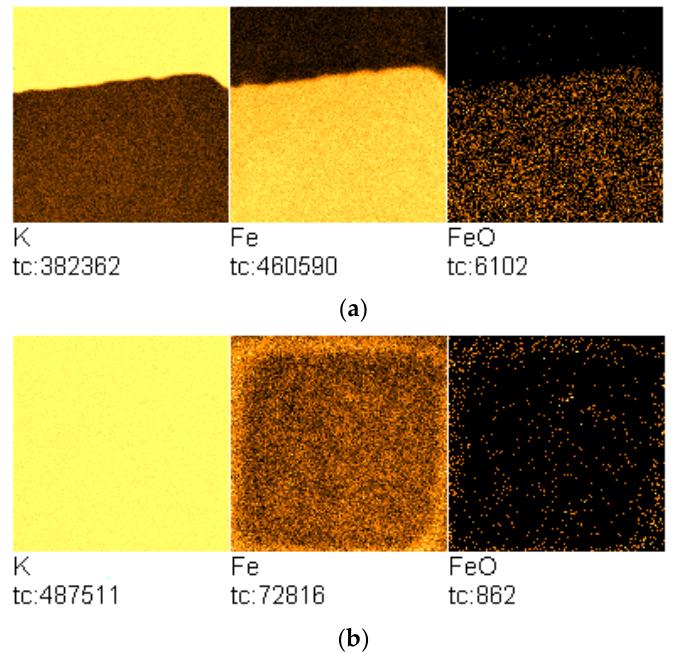
Figure 1. ( a ) TOF-SIMS image of the iron-sample surface with the visible region containing potassium oxide (field of view: 500 × 500 μm 2 ; sample Fe/KOH); ( b ) TOF-SIMS image of the sample surface containing the area on which TOF-SIMS temperature-programmed profile was performed (field of view: 500 × 500 μm 2 ; sample Fe/K-T). Total counts (tc) for particular ions are presented below each image.